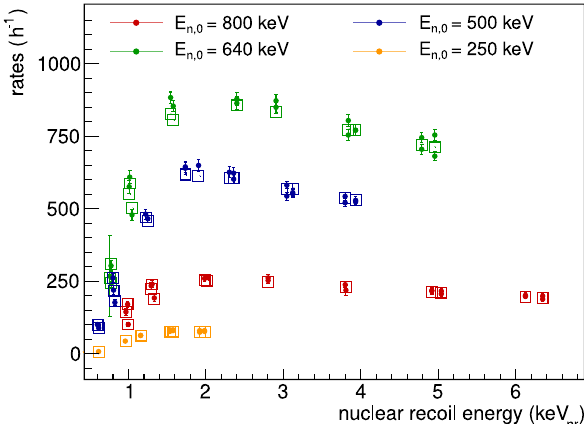
Fig. 11 Best fit coincidence rates (points) for each data set and cor- responding expectation (square) calculated from the global norm n d the neutron scattering cross section and the trigger efficiency. Rates are given per hour. Differences in current and neutron yield of the Li(p,n) reaction as a function of the energy explain the overall rate difference between the data